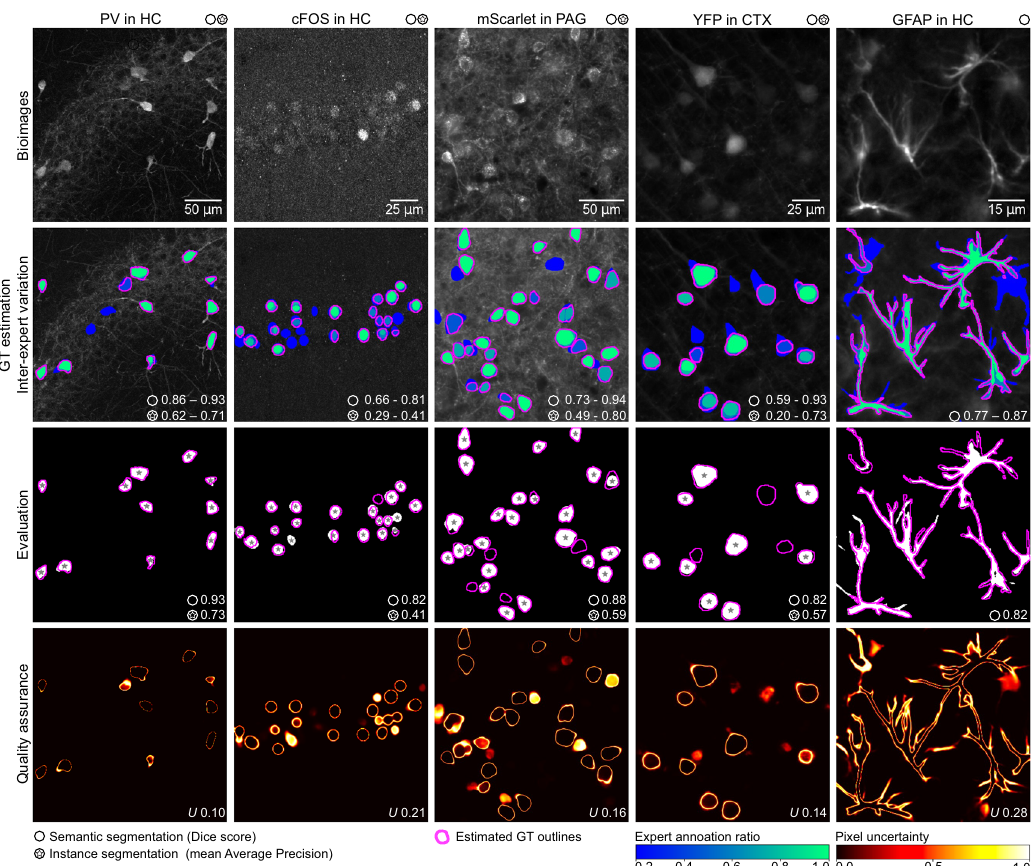
Fig. 2 | Exemplary results on different immuno fl uorescence images. Repre- sentative image sections from the test sets of fi ve immuno fl uorescence imaging datasets ( fi rst row) with corresponding expert annotations and ground truth (GT) estimation(secondrow).Theinter-expertvariationisindicatedwithranges(lowest and highest expert similarity to the estimated GT) of the Dice score (DS) for semantic segmentation and mean Average Precision (mAP) for instance segmen- tation. The predicted segmentations and the similarity to the estimated GT are